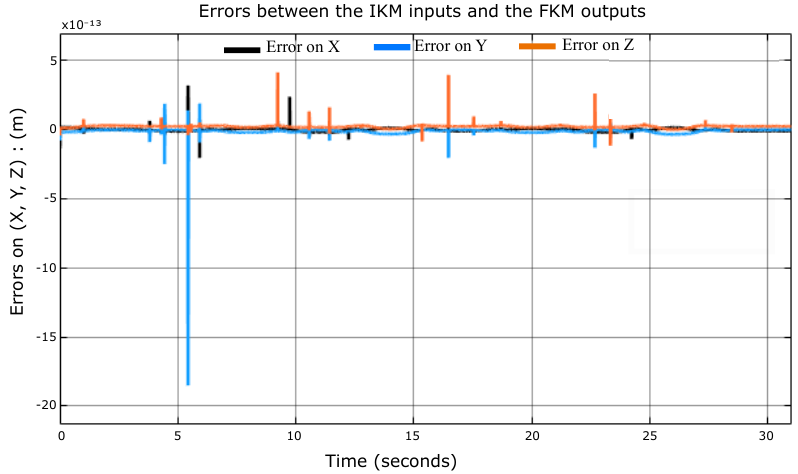
Figure 17. The error between the IKM inputs and the numerical FKM